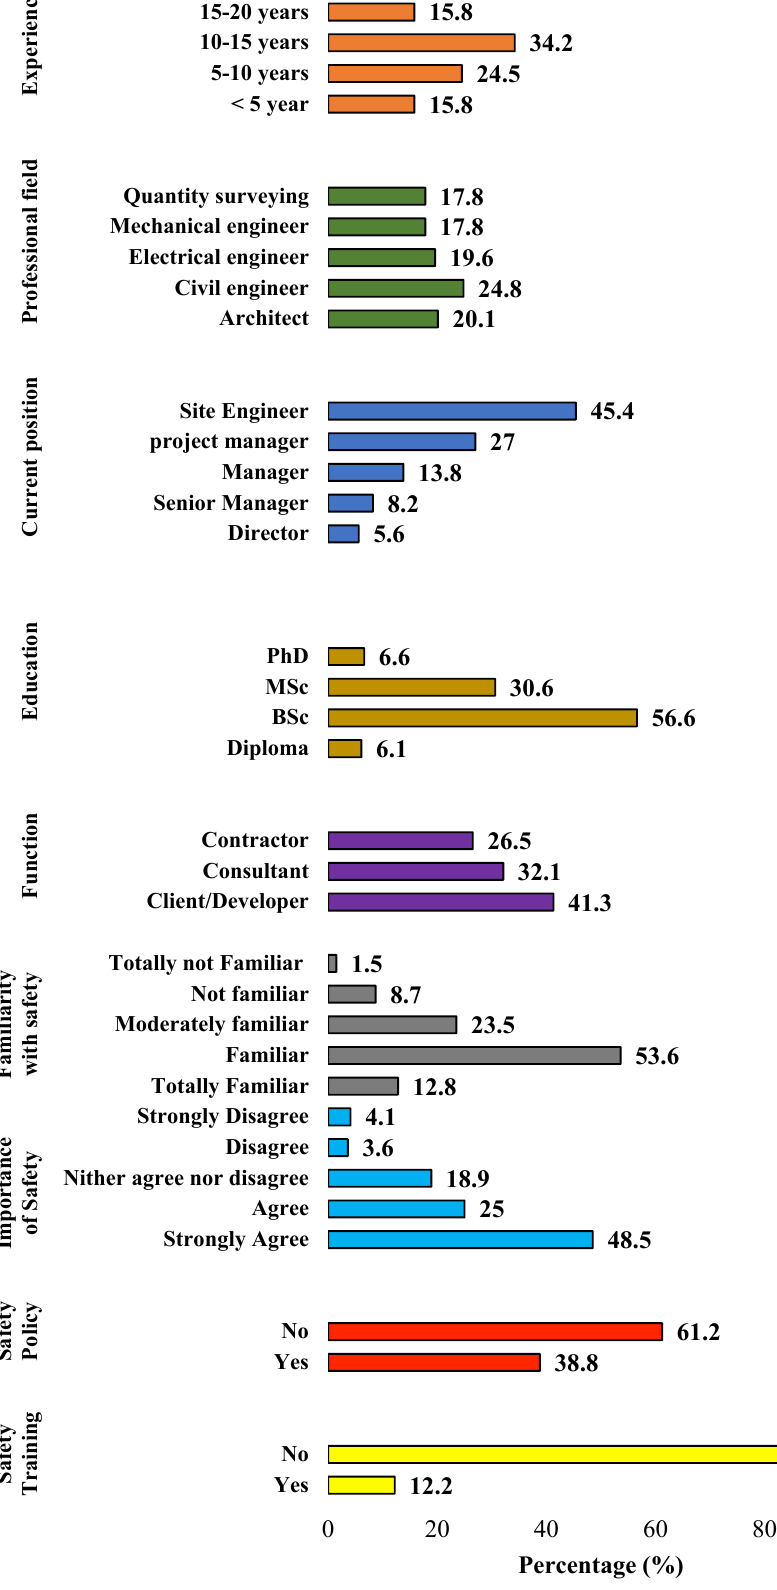
Figure 2. Demographic Profile.